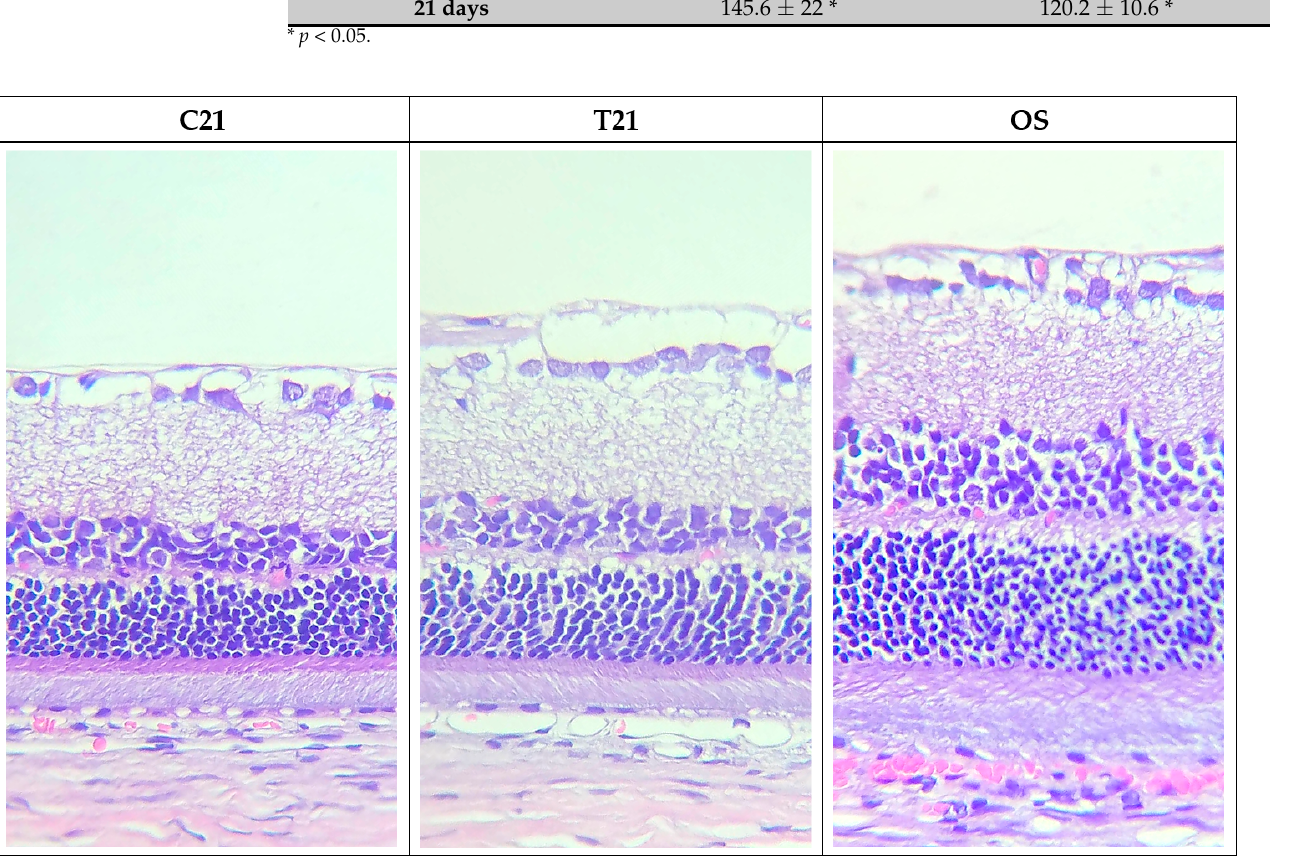
Figure 5. Photomicrographs of retinal sections from the OD, 21 days after glaucoma induction, from the control group (C21) and treated group (T21), and from a non-glaucomatous eye (OS; n = 4). We can observe that the improvement in retinal thickness was more pronounced in the treated group. Hematoxylin and eosin staining, 40 × magnification.